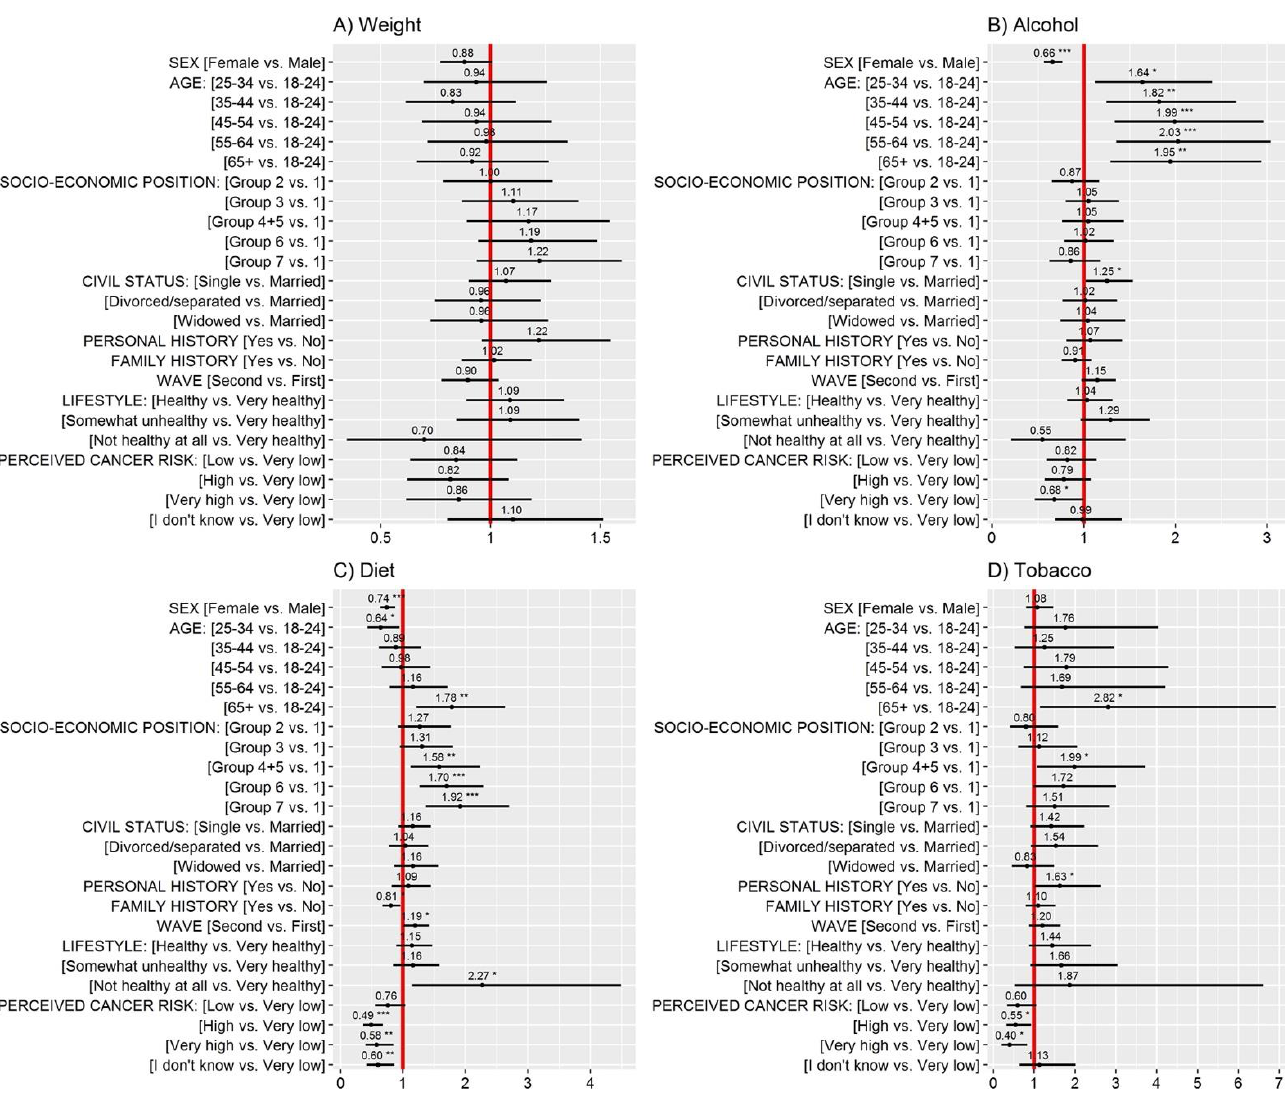
Figure 2. Odds ratios (OR, black dots) and 95% confidence intervals (CI) derived from multiple logistic regression models with outcomes influence ratings of ( A ) weight, ( B ) alcohol, ( C ) diet, and ( D ) tobacco on the development of cancer (1 = “low influence”; 0 = “high influence”). Note: * p < 0.05, ** p < 0.01, *** p < 0.001. If the OR and its CIs are to the left of the red reference line, the indicated group has a lower probability of assigning a “low influence” rating compared to the reference group. If the OR and its CIs are to the right of the red reference line, the indicated group has a higher probability of assigning a “low influence” rating to the risk factor compared to the reference group. For civil status, the category “Married” includes married and cohabiting.